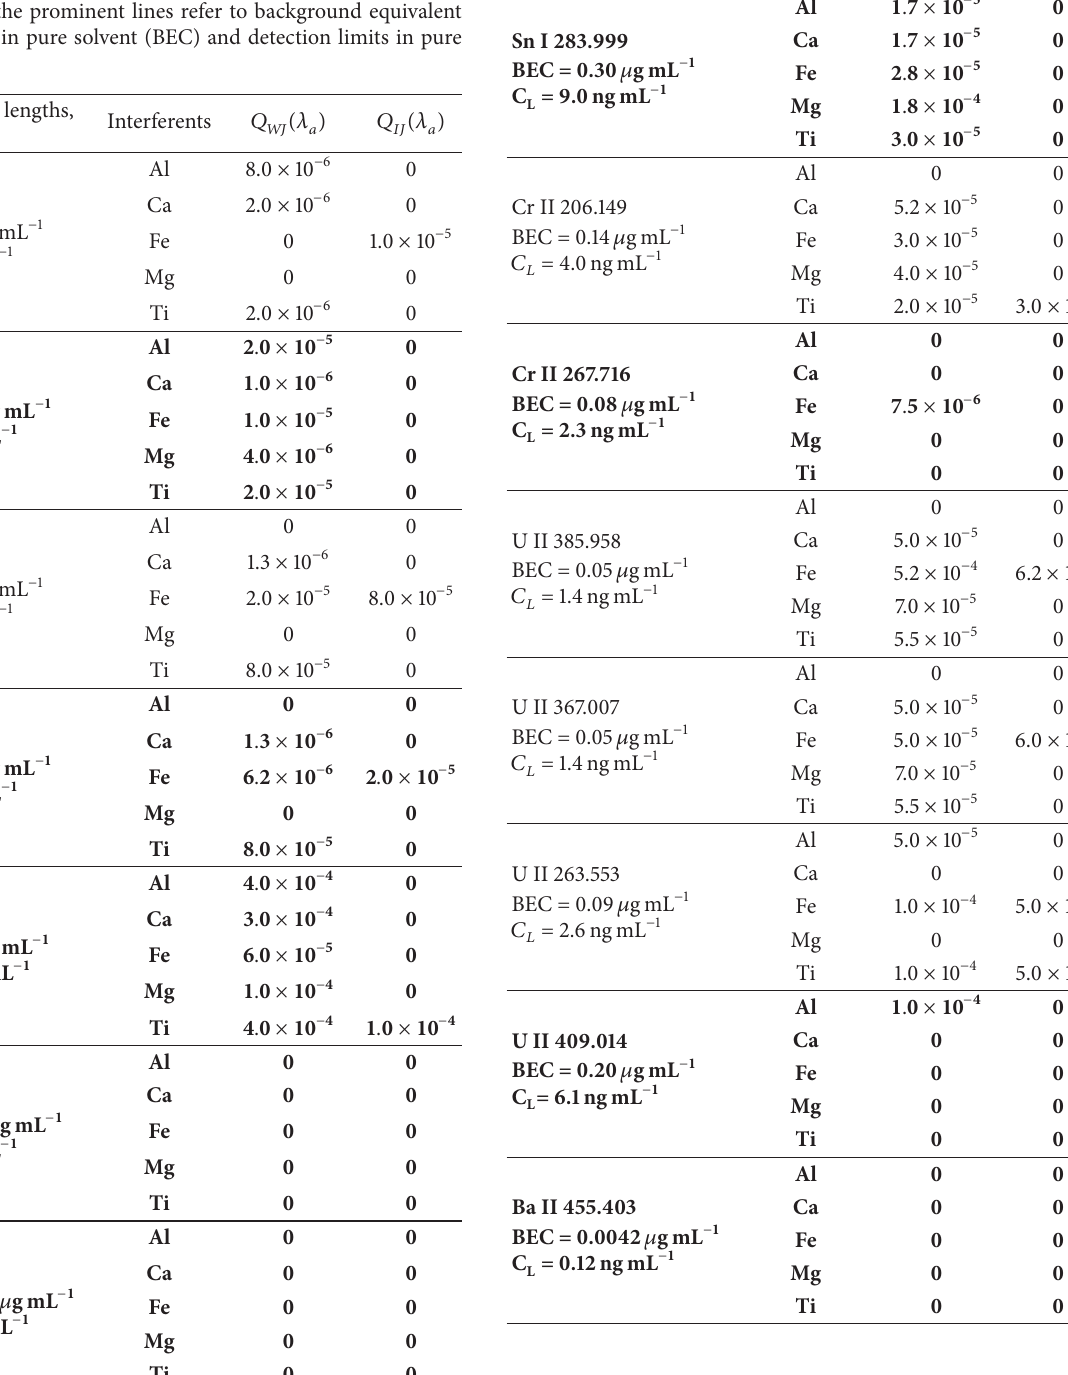
Analytes, wave lengths, 𝜆